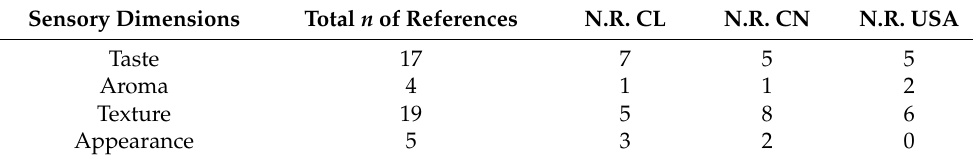
Table 5. Reference frequency by sensory dimension that contribute to children vegetable